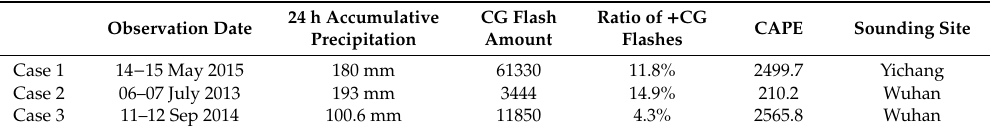
Table 1. Descriptive table of 2013–2015 strong convective events in Hubei Province, China selected for comparative analysis. CAPE (convective available potential energy) was derived from nearby sounding sites. Lightning amount: total quantity of + CG and − CG flashes. Ratio of + CG flashes: + CG percentage of + CG flashes to total